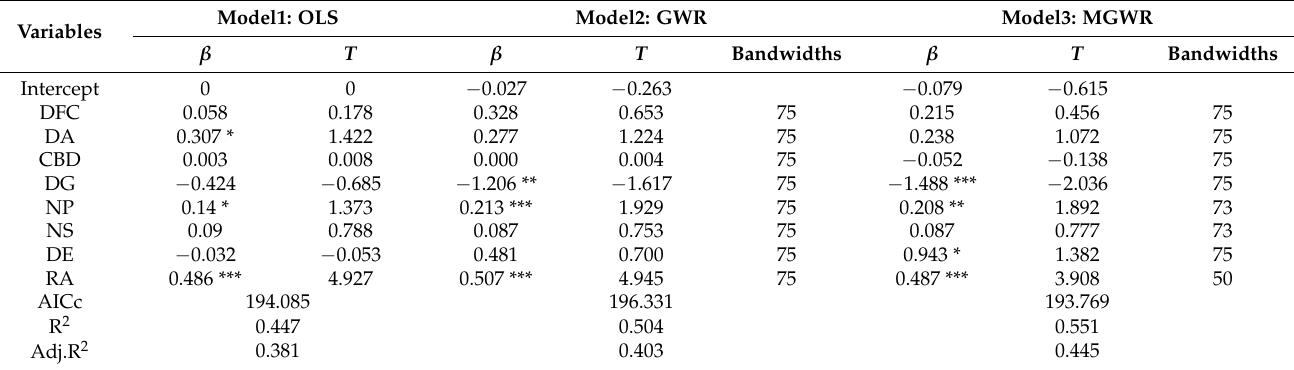
Table 5. Model results of OLS, GWR, and